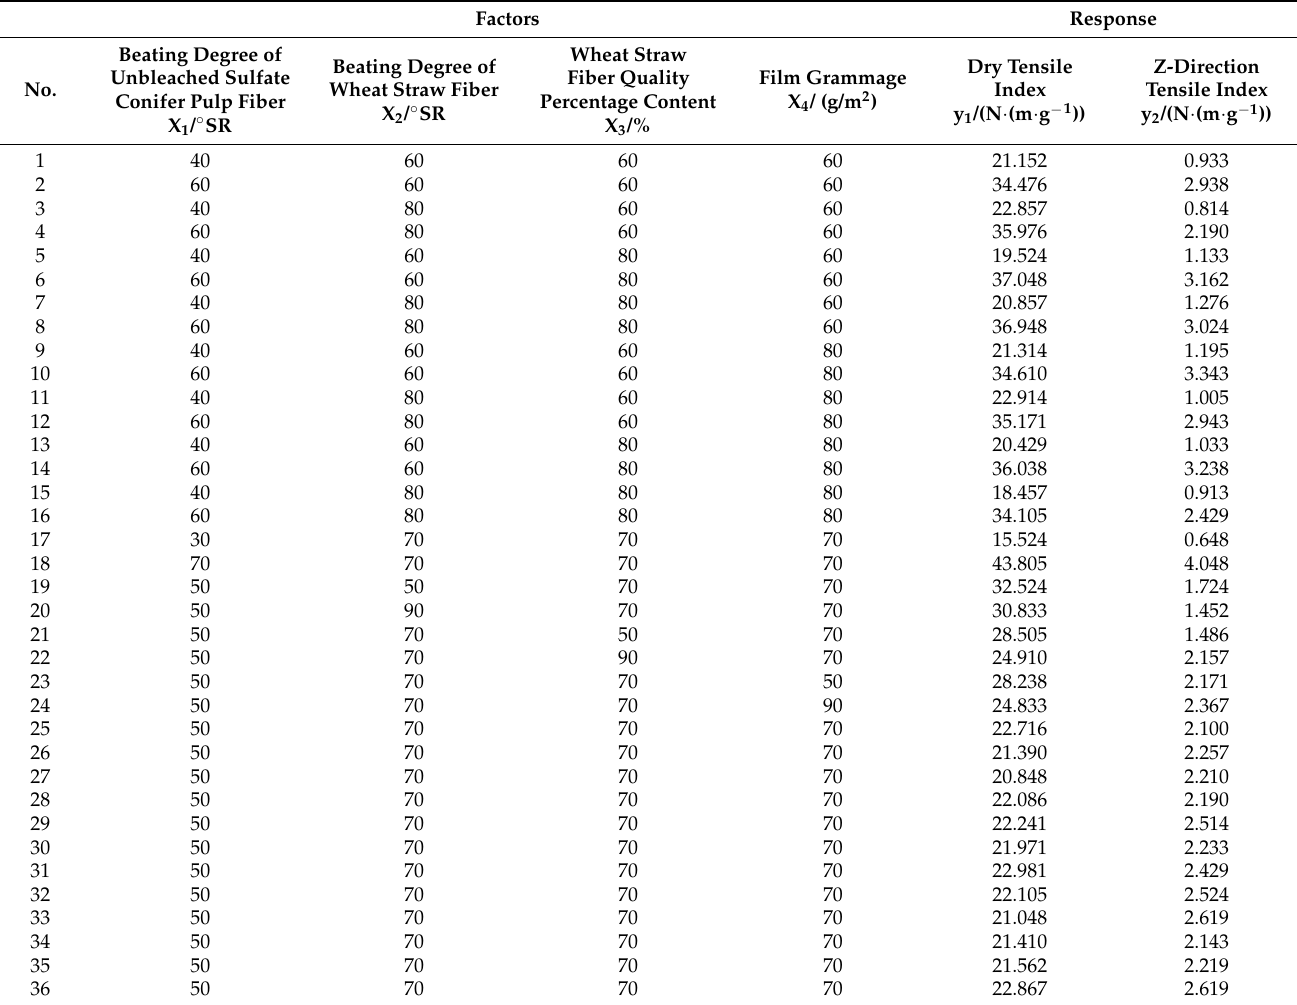
Table 2. Experimental plan and